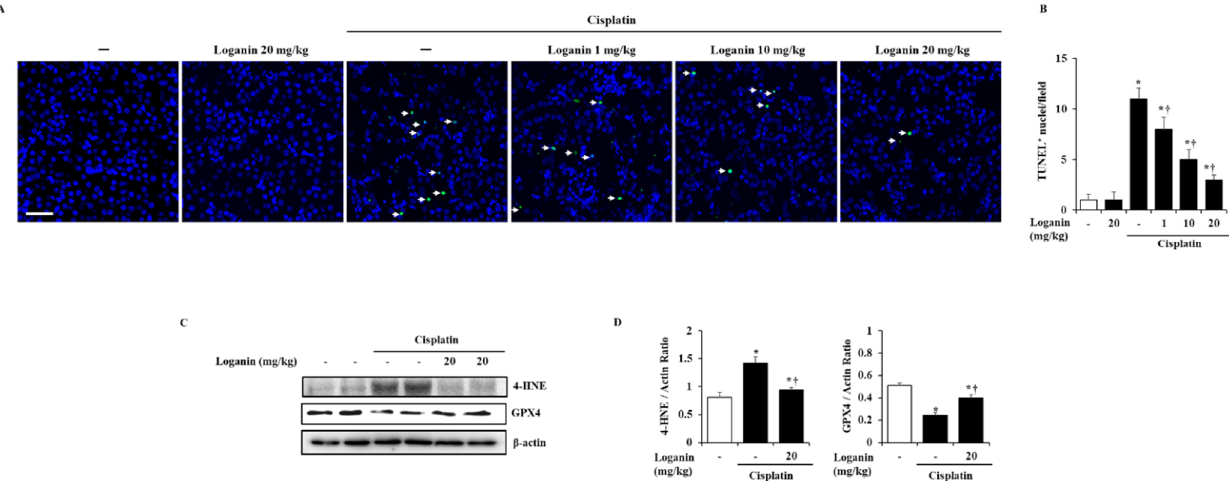
Figure 3. Effect of loganin on renal tubular apoptosis and ferroptosis in cisplatin-induced AKI. ( A ) Representative terminal deoxynucleotidyl transferase dUTP nick-end labeling (TUNEL)-stained sections of the kidney (600 × magnification). ( B ) TUNEL-positive cells (indicated by arrow) of the kidney were scored for green fluorescence. ( C ) Anti-4-hydroxynonenal (4-HNE) and glutathione peroxidase 4 (GPX4) were analyzed by Western blot. β -actin was used as a loading control. ( D ) The relative density ratio of 4-HNE/ β -actin and GPX4/ β -actin. Each experiment was repeated 3 times. Data are represented as mean ± SEM ( n = 9). An * indicates p < 0.05 vs. saline-treated control group; † indicates p < 0.05 vs. cisplatin treatment alone. Scale bar = 10 μ m.